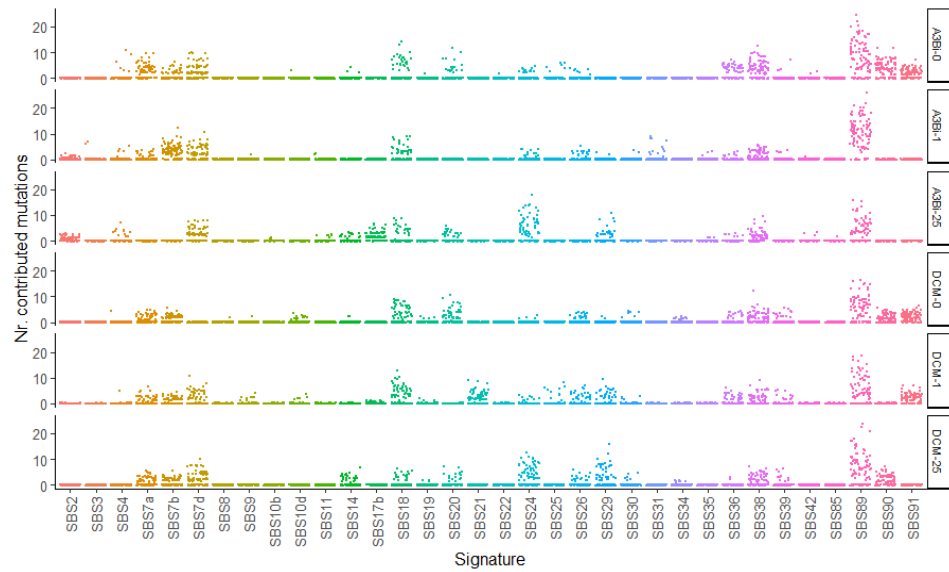
Figure 5. Mutational patterns detected in BK-MM strain BKPyV replicating in cell culture . Four rounds of BKPyV replication were performed on HEK-293 derived cells ex- pressing doxycycline inducible APOBEC3B (A3Bi) and APOBEC3B with an inactivated catalytic domain (DCM) in the absence (A3B-0, DCM-0) or presence of doxycycline (1 ng/mL A3B-1, DCM-1; 25 ng/mL A3B-25, DCM-25). Observed mutations were fitted to SBS signatures over 100 bootstrap iterations. Results are presented as a plot where each point represents the results of one fitting iteration.